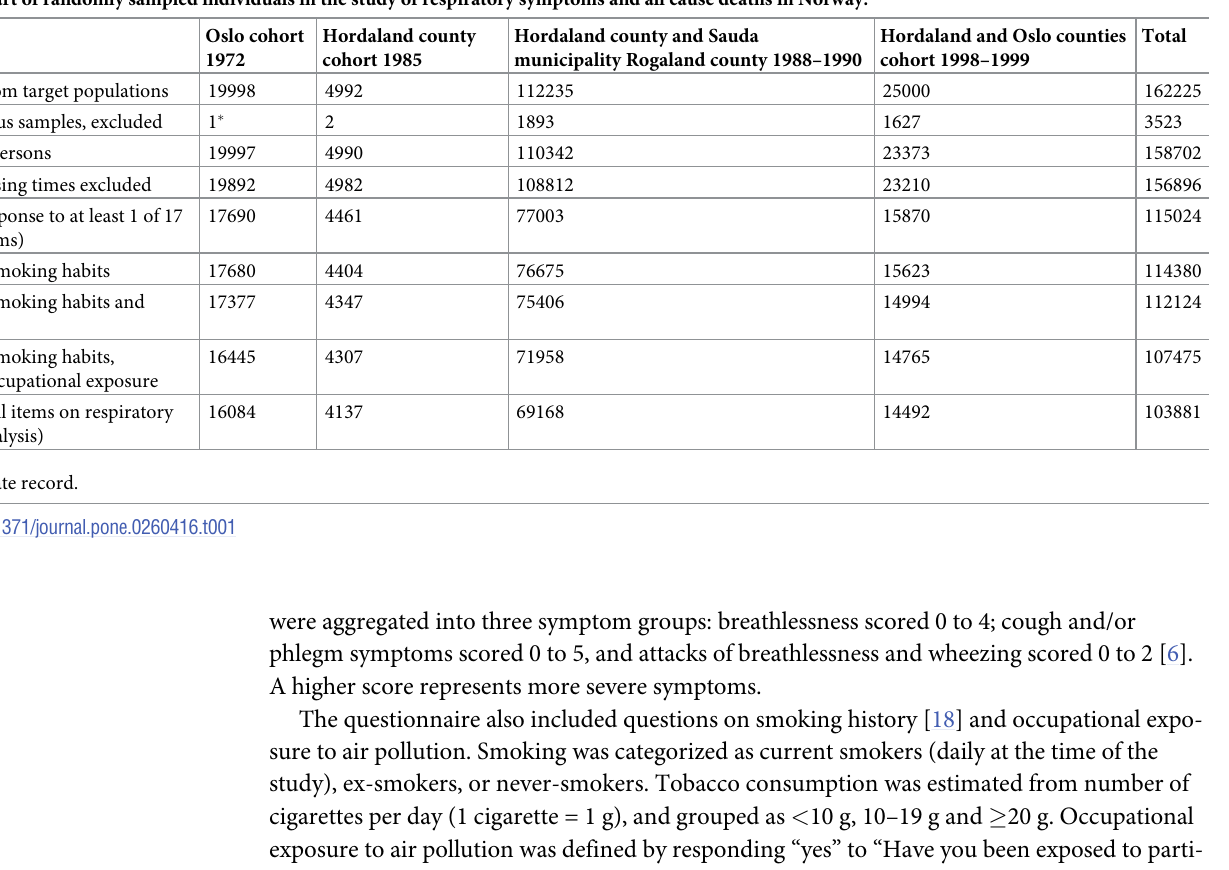
Table 1. Flowchart of randomly sampled individuals in the study of respiratory symptoms and all cause deaths in